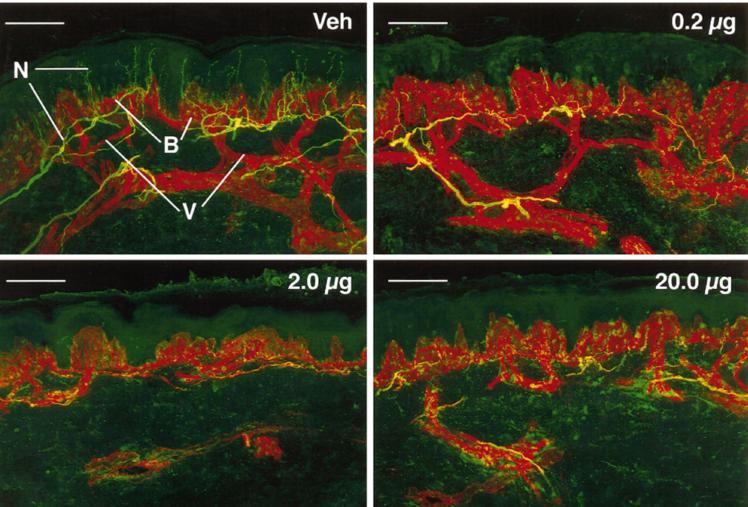
Figure 1. (Reprinted from [17], Copyright 1998 Society for Neuroscience) Confocal images of human epidermal biopsies from one individual who received vehicle and varying doses of capsaicin. Nerve fibers (N) immunoreactive for PGP 9.5 appear yellow-green, and basement membrane (B) and vessels (V) appear red. Biopsies were taken 72 h after injection of vehicle (Veh) or capsaicin doses of 0.2, 2.0 or 20 µ g. After the lowest dose of capsaicin, loss of PGP 9.5-immunoreactive nerve fibers was restricted to fibers located in the epidermis. Higher doses of capsaicin resulted in complete loss of PGP 9.5-immunoreactive epidermal nerve fibers plus various degrees of disruption or complete loss of the subepidermal nerve plexus. Scale bars = 100 µ